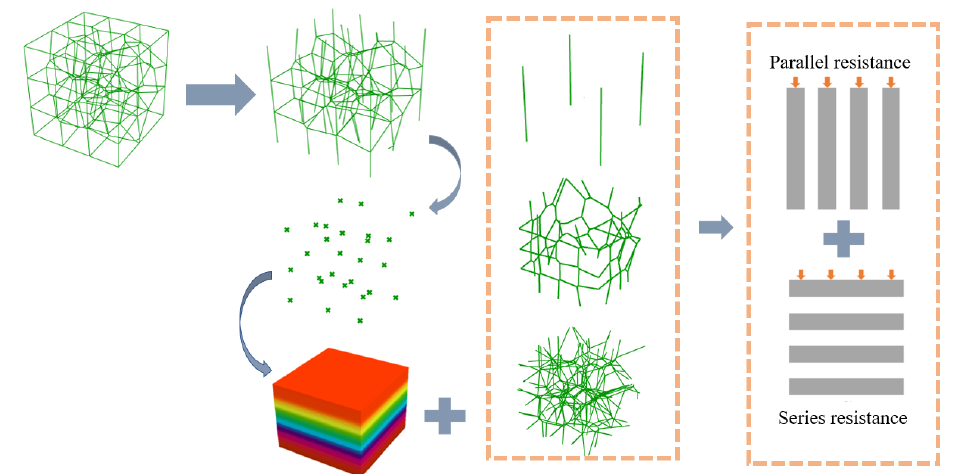
Figure 7. Calculation of the effective thermal conductivity of three-dimensional Voronoi random porous